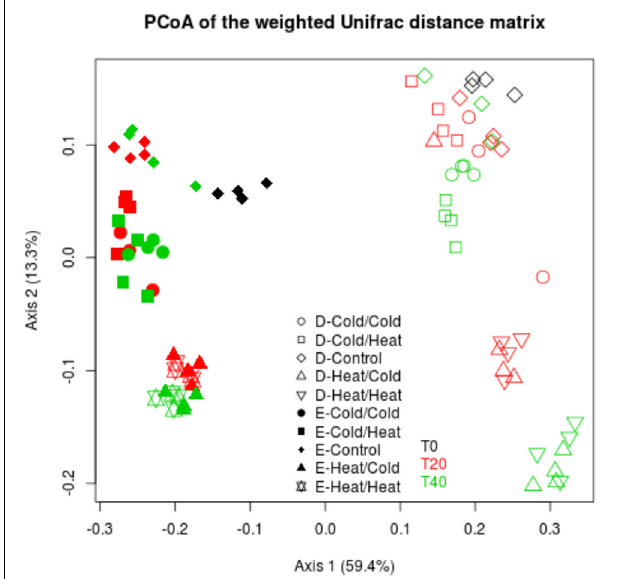
FIGURE 4 | Disturbance treatments affect bacterial community composition in soil E and soil D microcosms facing ongoing invasion and under a regimen of disturbance. Differences in community composition were estimated using the weighted UniFrac distance. This figure represents a PcoA of the weighted UniFrac distance matrix. Black, red and green colors correspond respectively to T0, T20, and T40 samples. Empty and filled symbols correspond to soil D and soil E,